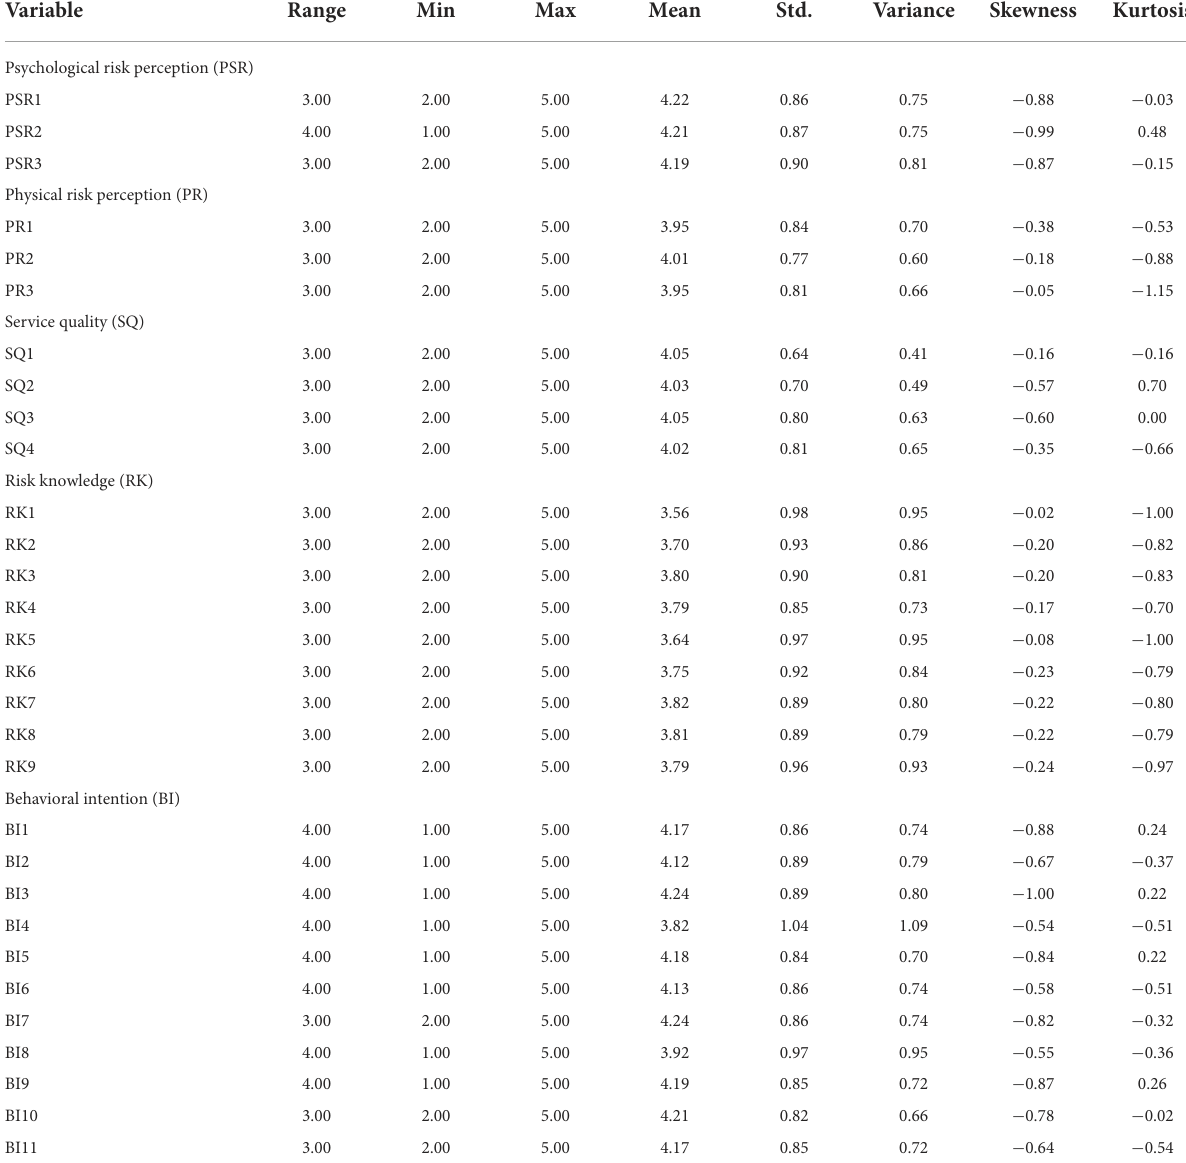
TABLE 5 Descriptive data distribution of the variable risk knowledge pathways to behavioral intention of air travel risk perception during COVID-19. Variable Range Min Max Mean Std. Variance Skewness